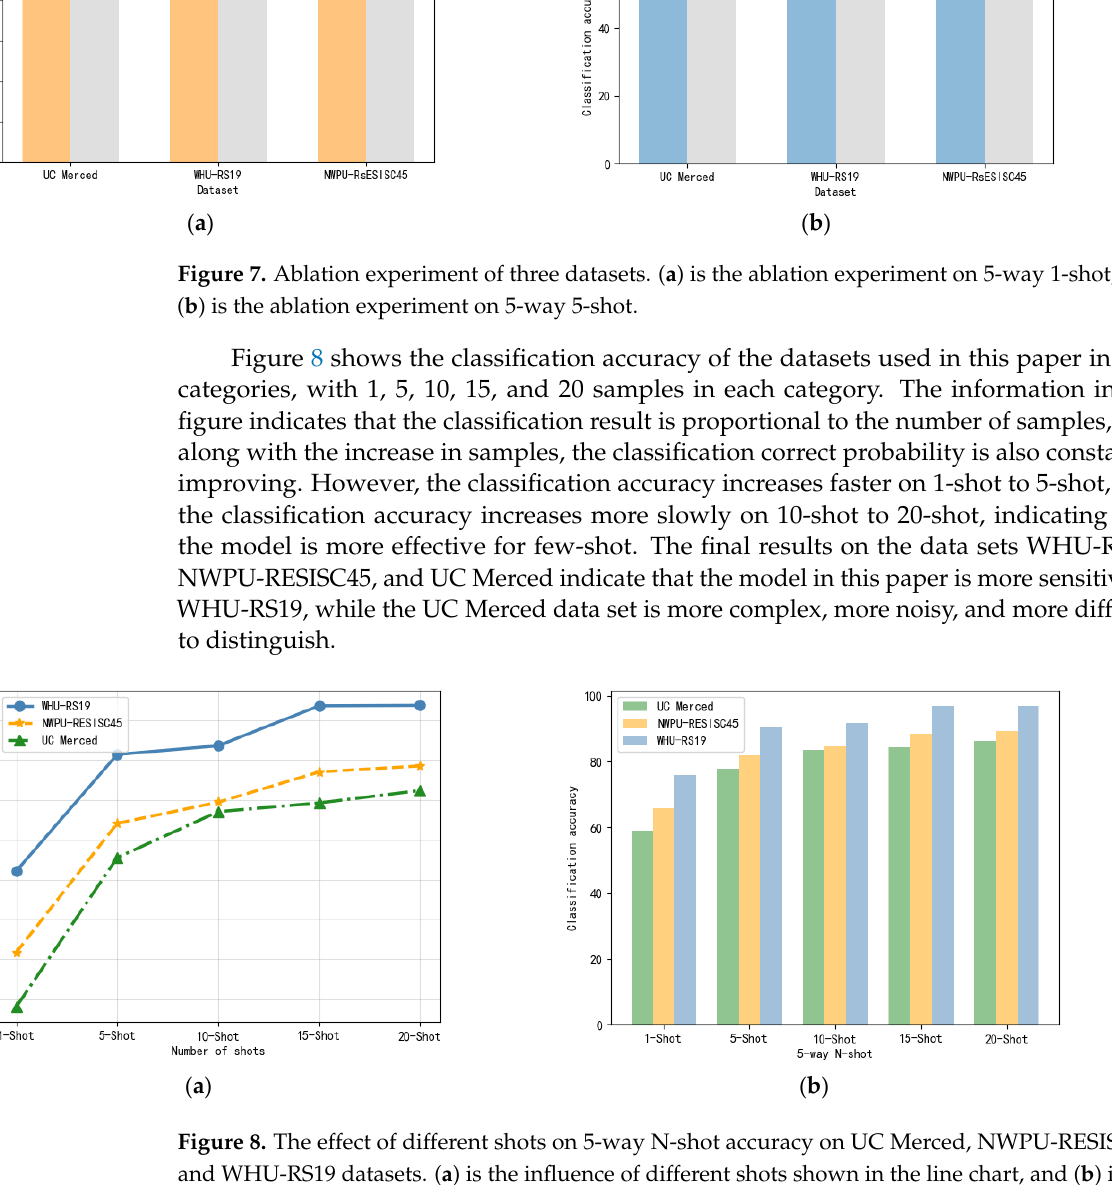
influence of different shots shown in the